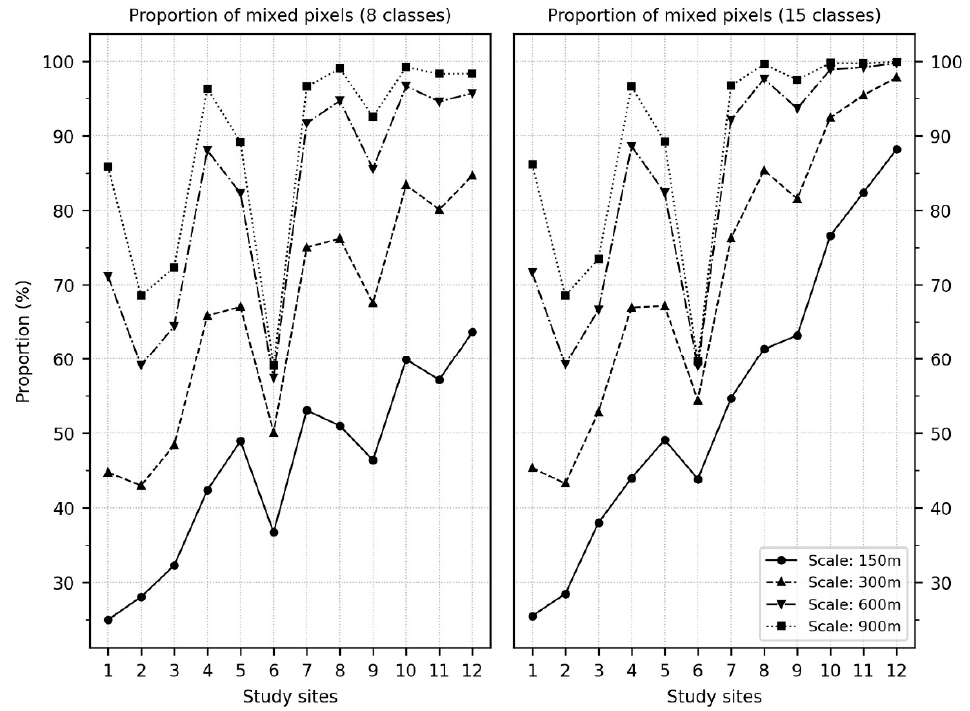
Figure 7. The proportion of mixed pixels of twelve study sites at different spatial scales.